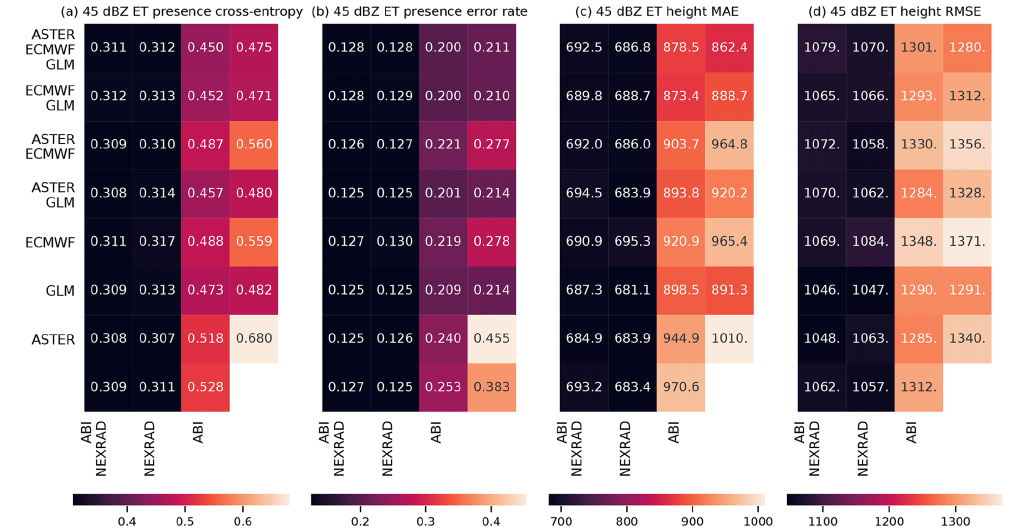
Figure 9. As Fig. 8, but for the ECHO45-OCC and ECHO45-HT predictands. In panel (b) , the bottom right corner shows the climatological occurrence (unlike with MAXZ, we do not use the persistence assumption as a baseline for ECHO45-HT, and therefore nothing is shown in the bottom right corner of panels (c) and (d) , in contrast to Fig. 8a and b). The results are shown for the 0–30min time